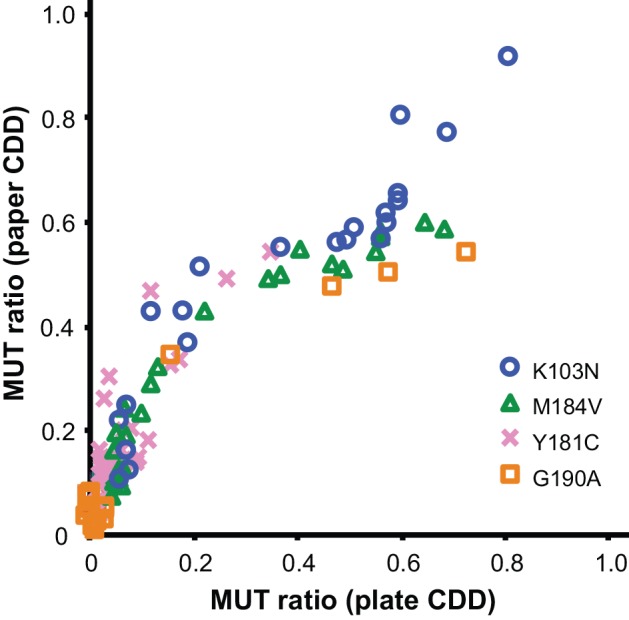
Correlation plot of MUT Ratios determined by paper capture, denaturation, and detection (CDD) versus plate CDD.MUT and WT signals obtained by paper and plate CDD format OLA at codons K103N, Y181C, M184V and G190A from 26 clinical specimens were used to calculate MUT Ratios. The overall shape reflects the signal saturation of the paper CDD at high MUT concentration, as seen in Figs 3–5. Results correlate strongly across clinical specimens and plasmid standards’ data (see S4 Fig for fitted correlation).